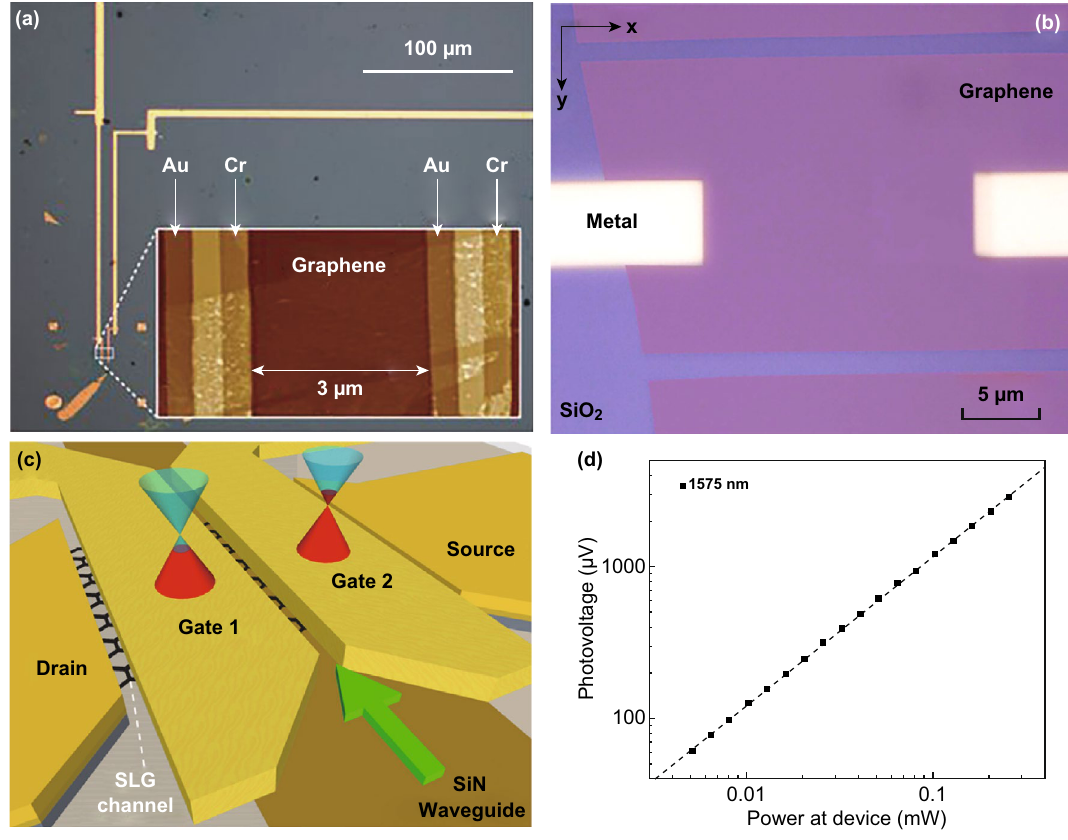
Fig. 17 a Optical micrograph and atomic force microscopy of graphene photodetector with asymmetric metal electrodes. Reproduced with per- mission from Ref. [266]. Copyright 2014, Springer Nature. b Optical micrograph of the graphene-based photodetector devices. Reproduced with permission from Ref. [61]. Copyright 2014, American Chemical Society. c Scheme of the single-layer graphene photodetector SiN waveguide. The green arrow indicates the light propagation direction. d The photovoltage V ph dependence of optical power. Reproduced with permission from Ref. [267]. Copyright 2019, American Chemical